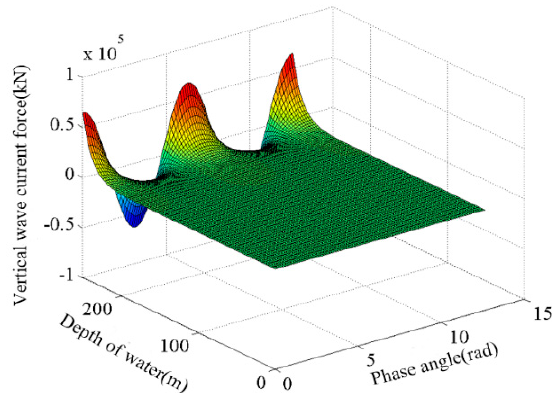
Figure 6. Variation of clamp wave flow force on vertical steel tube with water depth and phase angle.